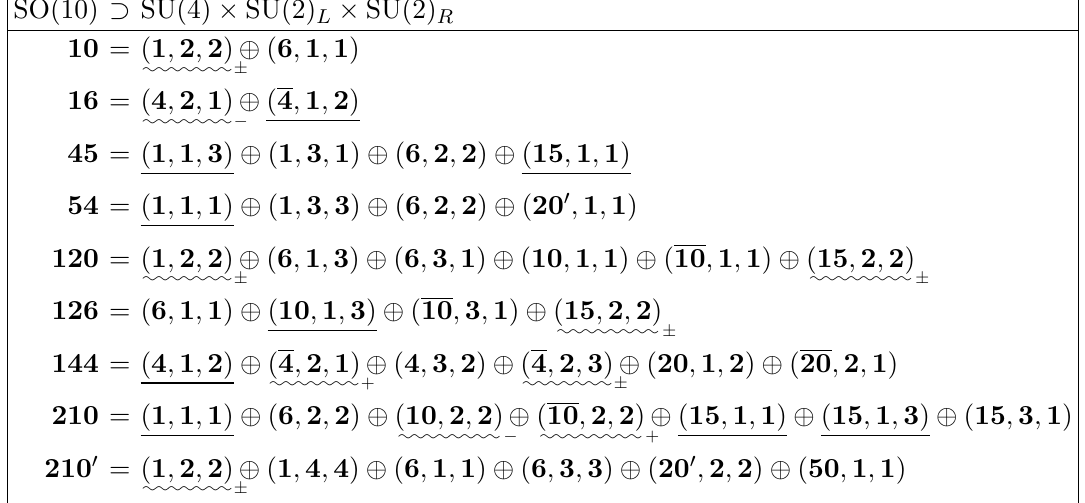
Table 11 . Decomposition of the lowest dimensional irreducible representations of SO(10) under the maximal subgroup G 422 (Pati-Salam group). Terms with a straight underline contain one SM singlet, whereas terms with a wavy underline contain one or two weak doublets, with a label of + or (cid:0) discriminating between ( 1 ; 2 ; (cid:6) 1 ) of the SM gauge group G 321 (with the symbol (cid:6) if both 2 are present).